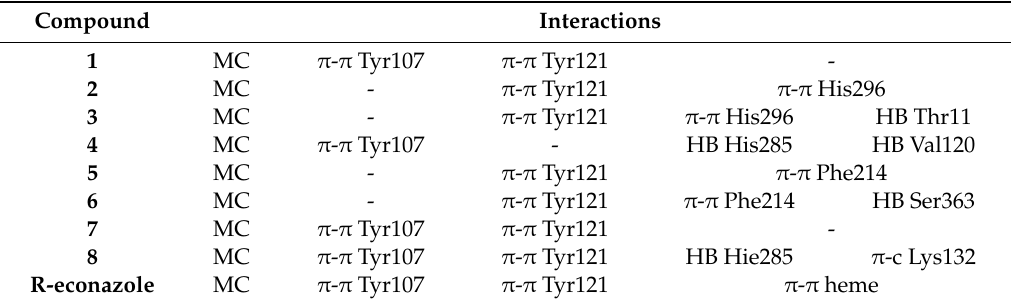
Table 5. Interactions of compounds 1–8 , developed in the active site of Aspergillus fumigatus CYP51A modeled enzyme.